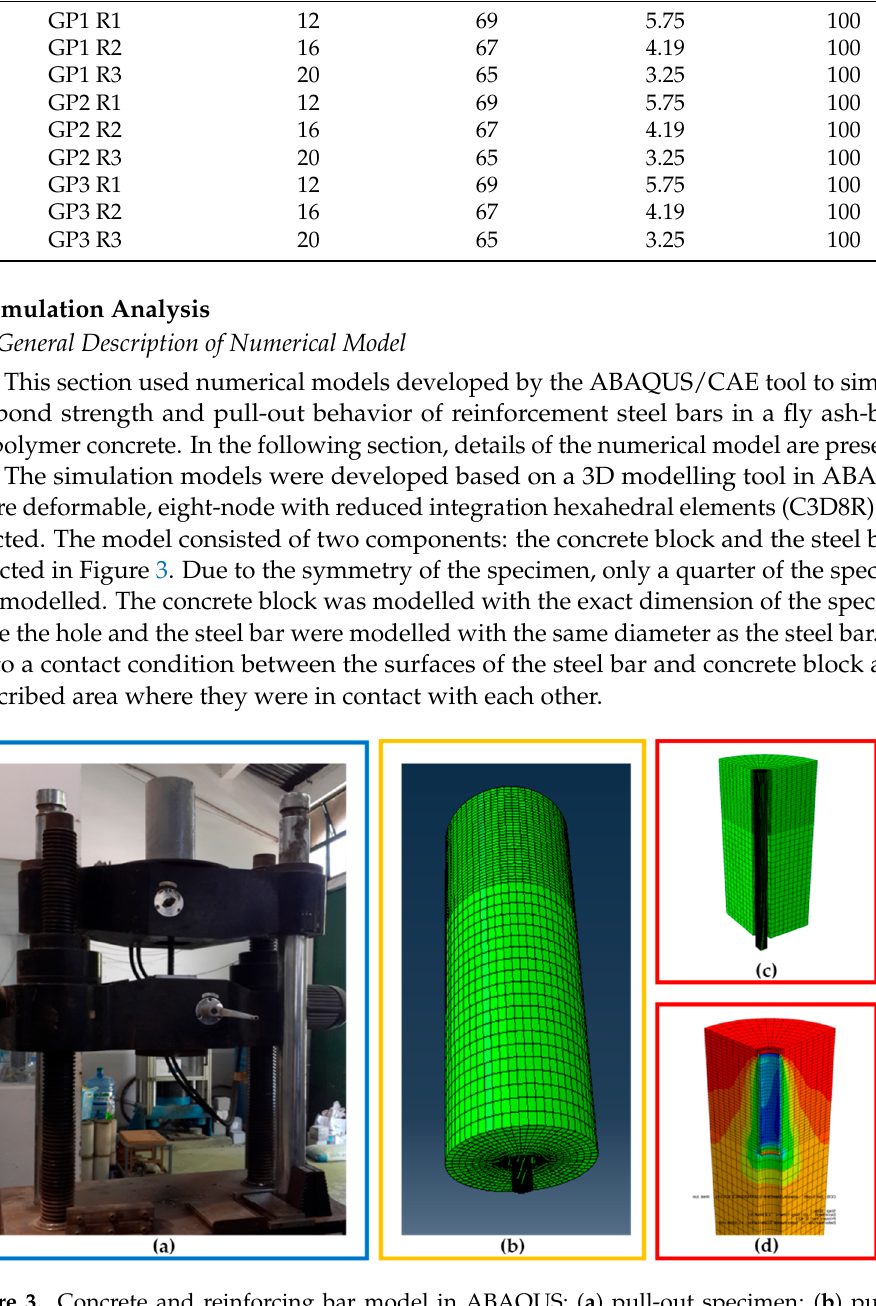
Table 4. Details of geopolymer concrete specimens.